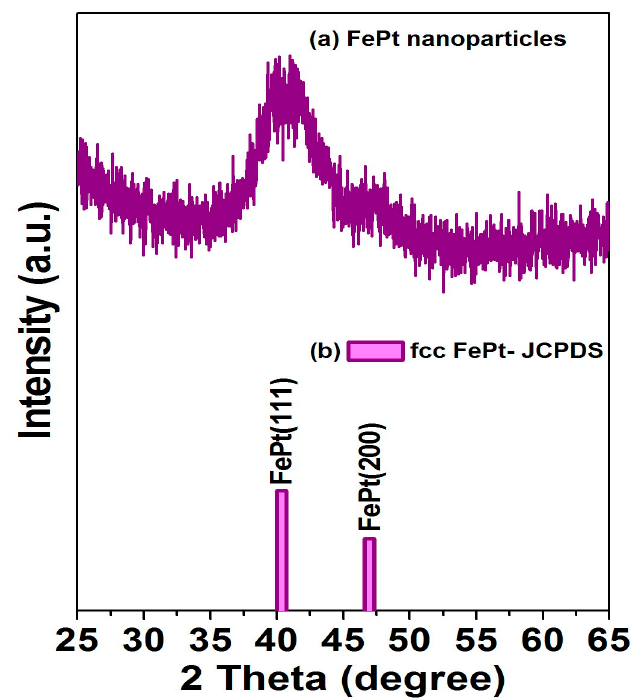
Figure 2. ( a ) X-ray diffraction patterns for the FePt NPs synthesized in phenyl ether; ( b ) diffraction pattern is the corresponding standard Joint Committee on Powder Diffraction Standards (JCPDS) of disordered fcc FePt phase.